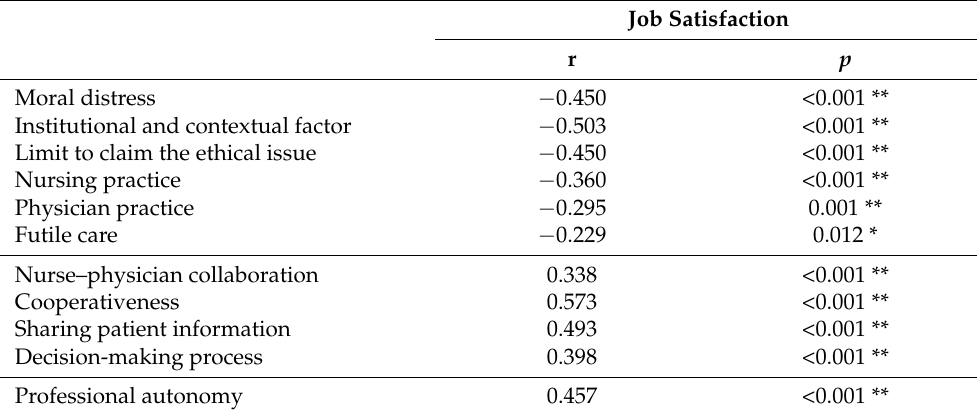
Table 3. Correlation among job satisfaction, nurse–physician collaboration, moral distress, and professional autonomy (n =